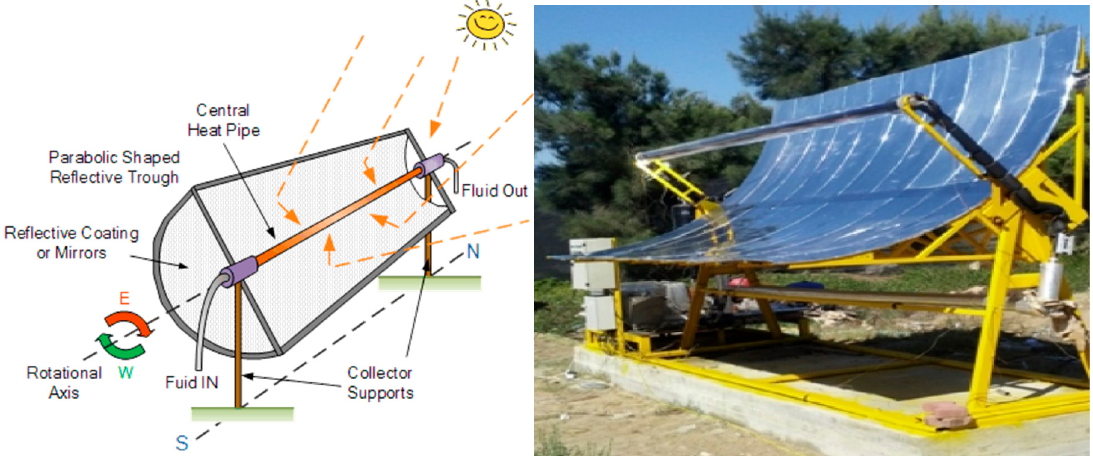
Figure 1. Schematic drawing of a parabolic through collector [43].